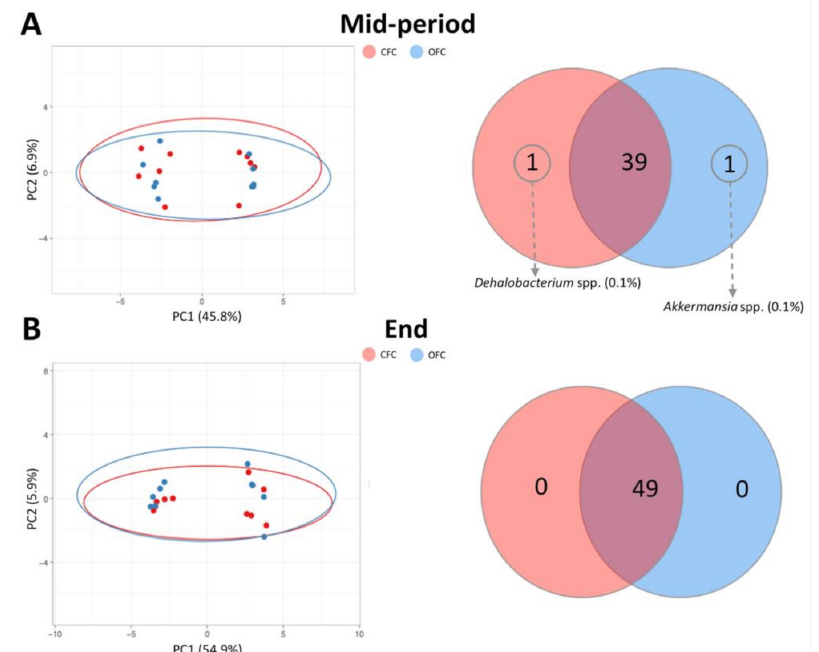
Figure 2. Evaluation of the beta diversity based on Bray–Curtis dissimilarity and comparison of genera presence in commercial and optimal farm conditions. ( A ) Principal Coordinate Analysis graphic and similar vs. different genera for both experimental groups at mid-period. ( B ) Principal Coordinate Analysis graphic and similar vs. different genera for both experimental groups at the end of the growing